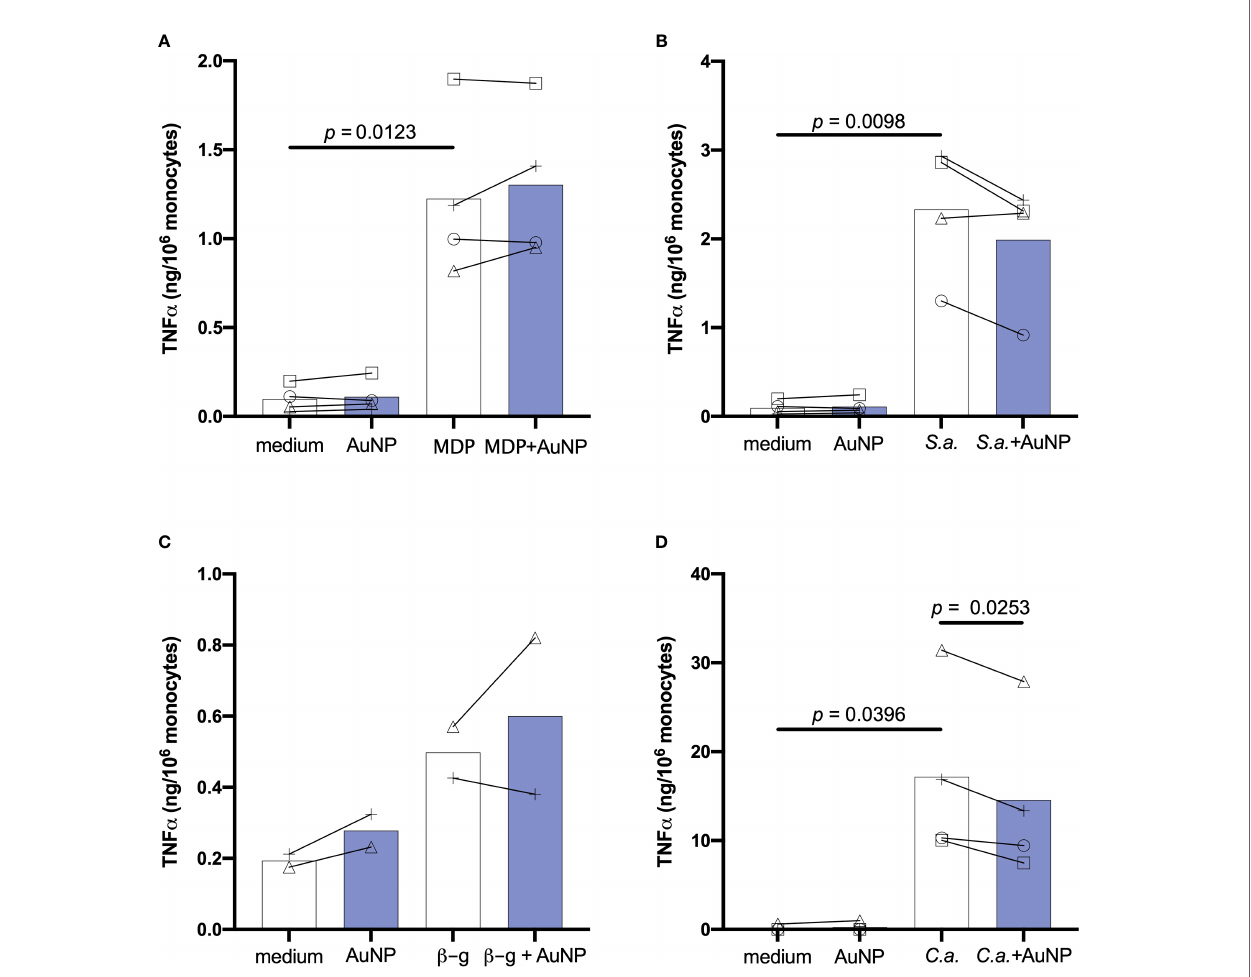
FIGURE 2 | Effect of AuNPs on the primary response of monocytes exposed to soluble or particulate microbial stimuli. CD14 + monocytes were exposed to MDP (10 µg/mL) (A) , S. aureus (ratio 1:1; S.a. ) (B) , b -glucan (2 µg/mL; b -g) (C) or ( C ) albicans (ratio 0.1:1; C.a. ) (D) for 24 h in the presence or absence of AuNPs (20 µg/mL, indicated by blue bars). The in fl ammatory response is reported in terms of production of TNF a (ng/10 6 monocytes). Values from individual donors are depicted concurrent with mean cytokine production. Relevant p values are indicated when < 0.05. n = 4 (A, B, D) , n = 2 (C)